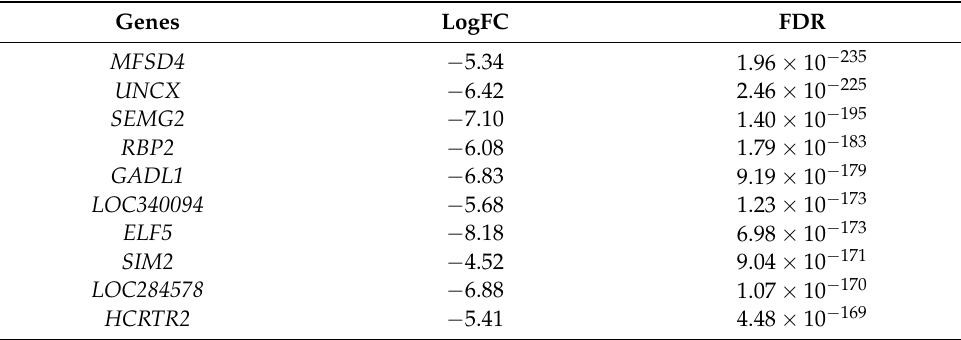
Table 3. List of the ten most significant DEGs found between tumor and normal tissues from KIRC patients. LogFC—log fold change; FDR—false discovery rate.